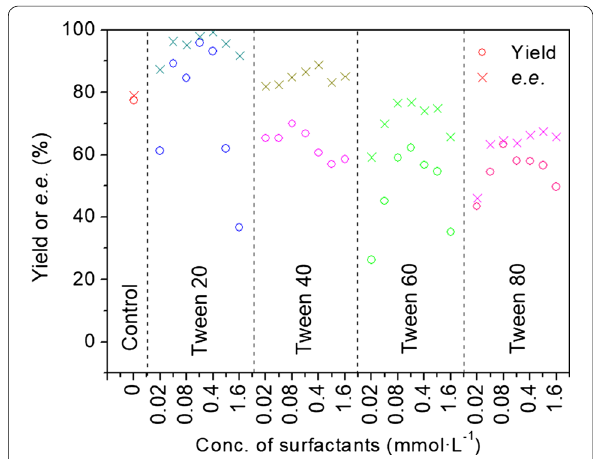
Fig. 3 Effect of Tween surfactants on asymmetric reduction of 2-octanone with baker’s yeast cells. Reaction condition: 10 mmol L − 1 2-octanone; 150 g L − 1 wet cell; 10 g L − 1 glucose/24 h; 20 mL Tris–HCl buffer (50 mmol L − 1 , pH 8.0); 32 °C; 200 r min − 1 ; anaerobic; 96